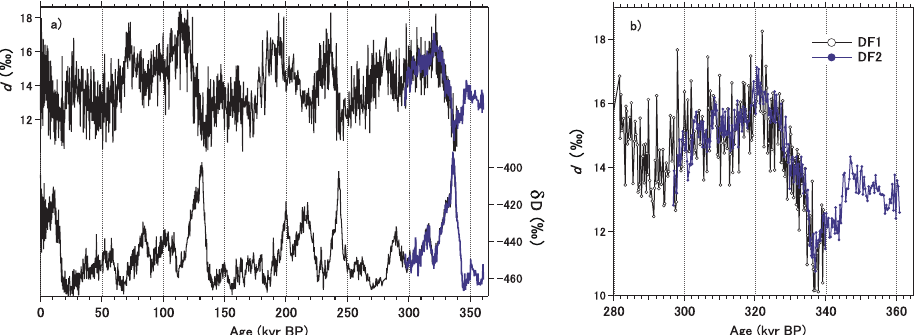
Fig. 2. δ D and deuterium-excess records from the DF ice cores. (a) δ D and d records from DF1 (black lines) and DF2 (blue lines) cores. (b) Enlarged view of the d records during the overlapping period. Here, δ = R sample / R VSMOW − 1, and R sample and R VSMOW are the isotope ratios (D/H and 18 O/ 16 O) of sample and VSMOW,